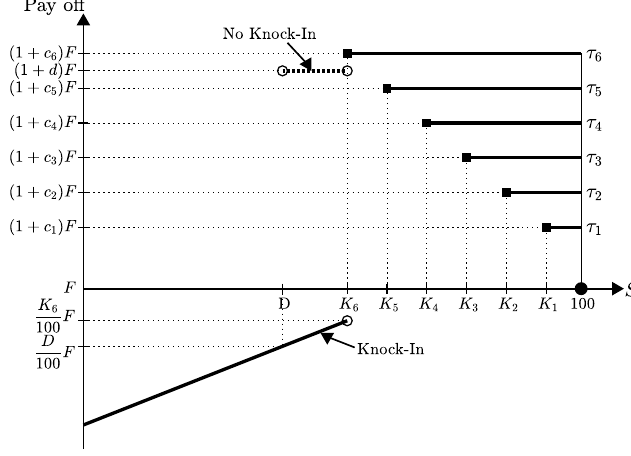
Figure 1. Payoff structure of a one-asset step-down